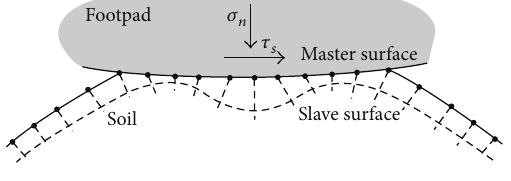
Figure 24: Footpad and soil in contact.